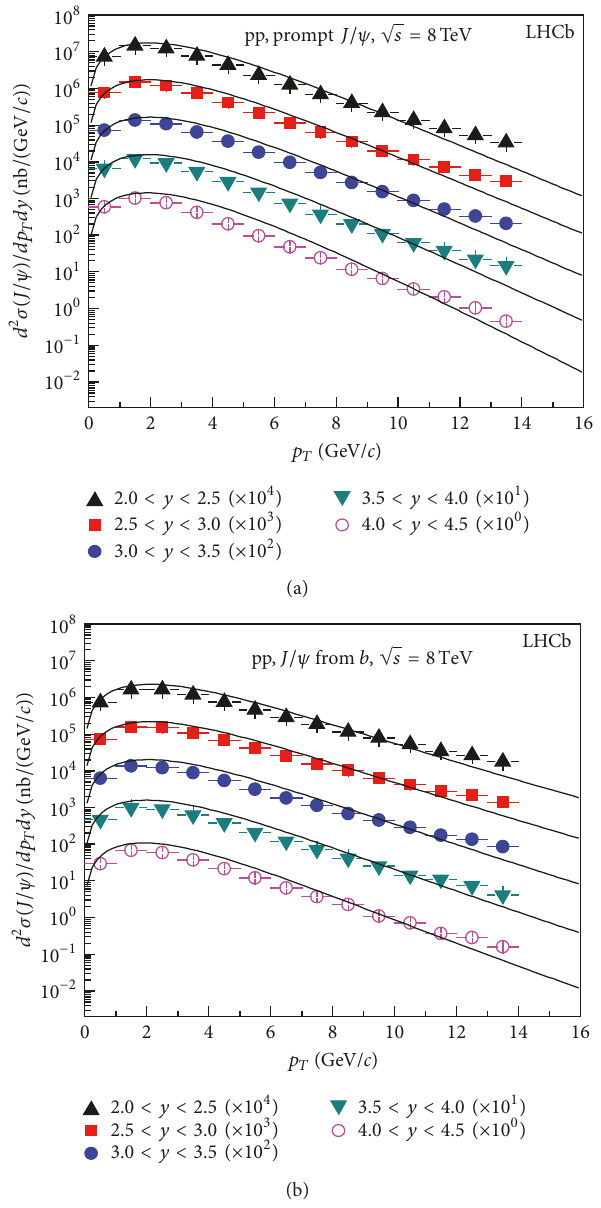
Figure 2: Double-differential cross section 𝑑 2 𝜎/𝑑𝑝 𝑇 𝑑𝑦 as a function of 𝑝 𝑇 in bins of 𝑦 for (a) prompt 𝐽/𝜓 and (b) 𝐽/𝜓 from 𝑏 in p-p collisions at √𝑠 NN = 8 TeV. The symbols indicate the experimental data of the LHCb Collaboration [25]. The solid lines indicate our theoretical calculations.